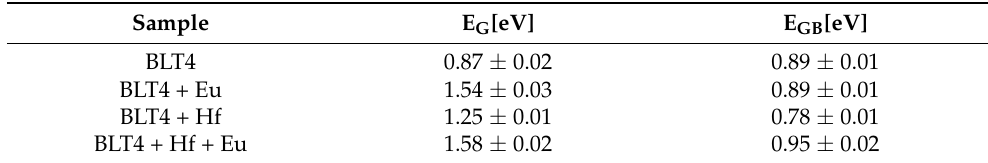
Figure 12. Dependence of the natural logarithm of the grains resistivity (R G ) ( a ) and grain bounda- Table 7. The values of activation energy of the conduction process in the grain (E G ) and grain ries resistivity (R GB ) ( b ) values calculated on the basis of impedance spectra as a function of the temperature inverse of pure and modified BLT4 ceramics. boundaries (E GB ) of pure and modified BLT4